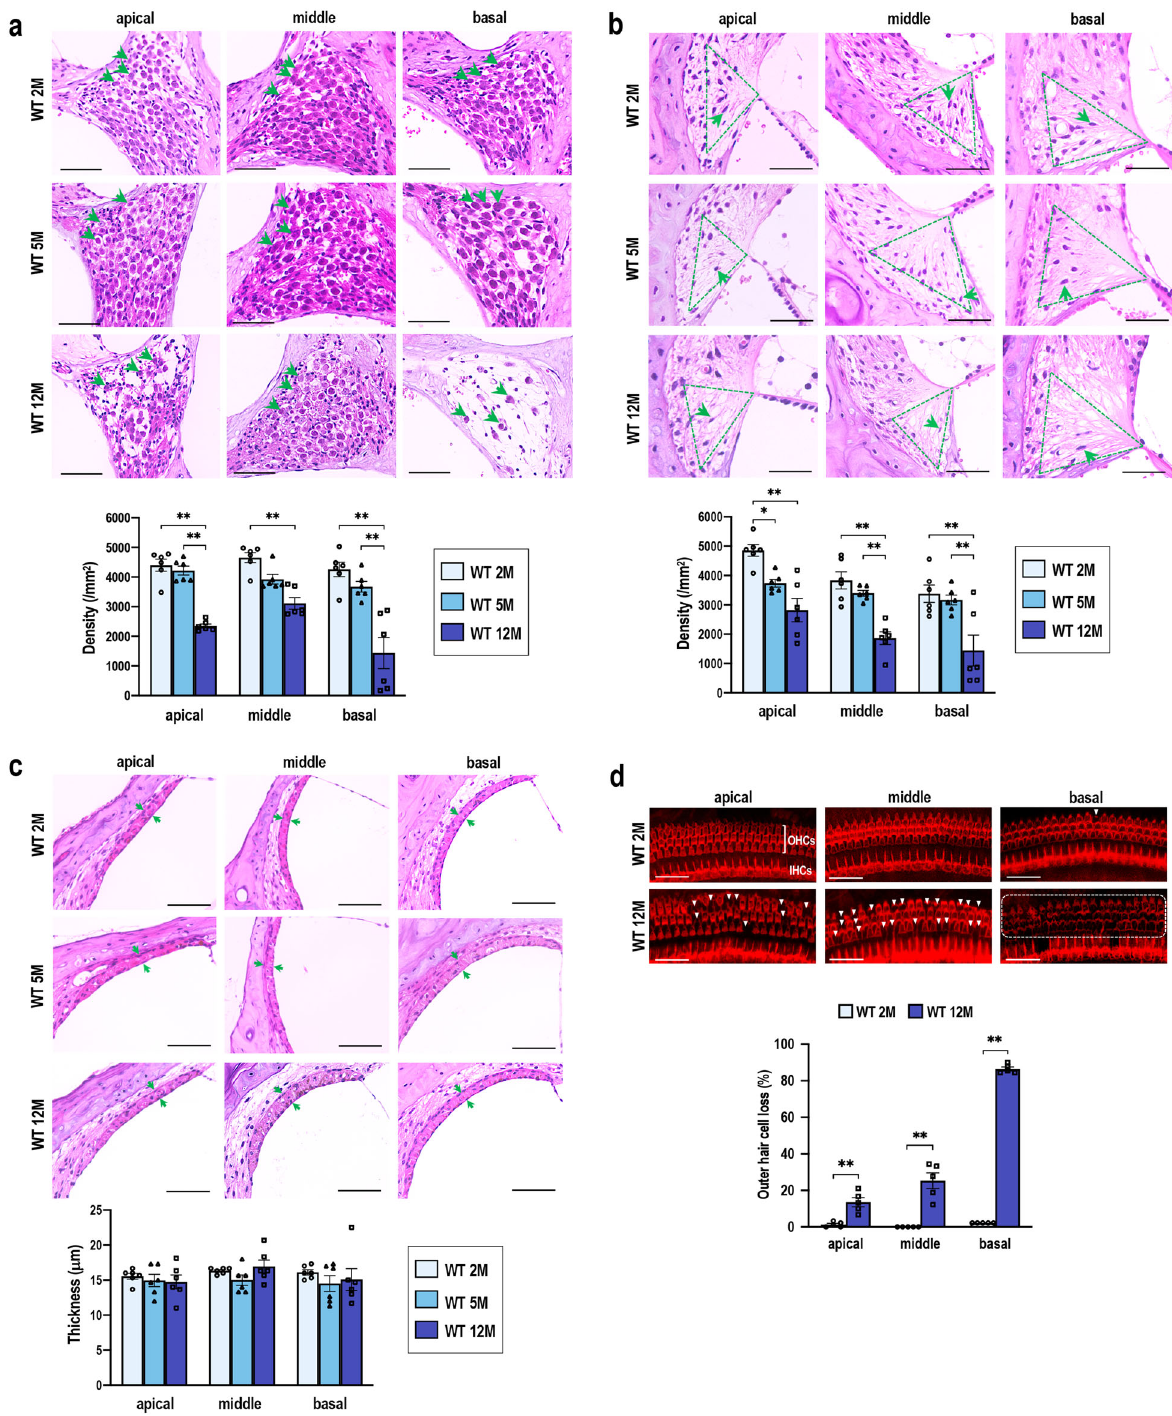
Fig. 2 Progression of cochlear degeneration in the WT C57BL/6 mice during aging. a – c Histological analysis of spiral ganglion neurons (SGNs) ( a ), spiral ligaments (SL) ( b ), and stria vascularis (SV) ( c ) at the apical, middle, and basal turns in the 2-, 5-, and 12-month-old mice ( n = 6 in each group). SGN density ( a ), type IV fi brocyte density in the SL ( b ), and SV thickness ( c ) were quanti fi ed. Green arrows indicate neuronal soma ( a ), fi brocytes ( b ), and SV width ( c ). Areas of type IV fi brocytes are indicated by dashed green triangles. The data represent the mean ± SEM. * P < 0.05, ** P < 0.01. Two-way ANOVA followed by Tukey ’ s multiple comparison test was applied. d Images of the surface preparation of the hair cells at 2 and 12 months. Missing outer hair cells (OHCs) are indicated with white arrowheads. Most OHCs in the basal turns at 12 months were lost, as indicated in the area circumscribed by the dashed line. IHCs, inner hair cells. Missing OHCs were quantitatively analyzed by evaluating 90 OHCs at each turn ( n = 5 in each group). The data represent the mean ± SEM. ** P < 0.01. Unpaired two-tailed Student ’ s t -test was applied. Scale bars correspond to 50 μ m ( a – c ) and 40 μ m ( d